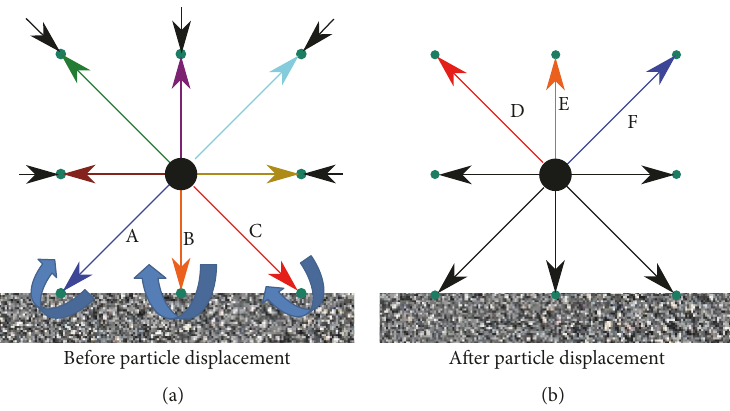
Figure 8: Bounce back conditions of fluid particles for a node at the fluid/rock interface. (a) Colored vectors are streamed to neighboring nodes and black vectors towards the node at the fluid rock interface. Particles travelling into the solid surface are represented by vectors “A,” “B,” and “C.” (b) Black vectors of the neighboring nodes have been streamed to the node at the fluid/rock interface and, correspondingly, colored vectors haven been streamed to neighboring nodes. Vectors “A,” “B,” and “C” cannot be streamed towards a neighboring node, since particle displacement is interrupted by the solid surface. The latter vectors were therefore bounced back according to vectors “D,” “E,” and “F” with, respectively, the same directions but in the opposite